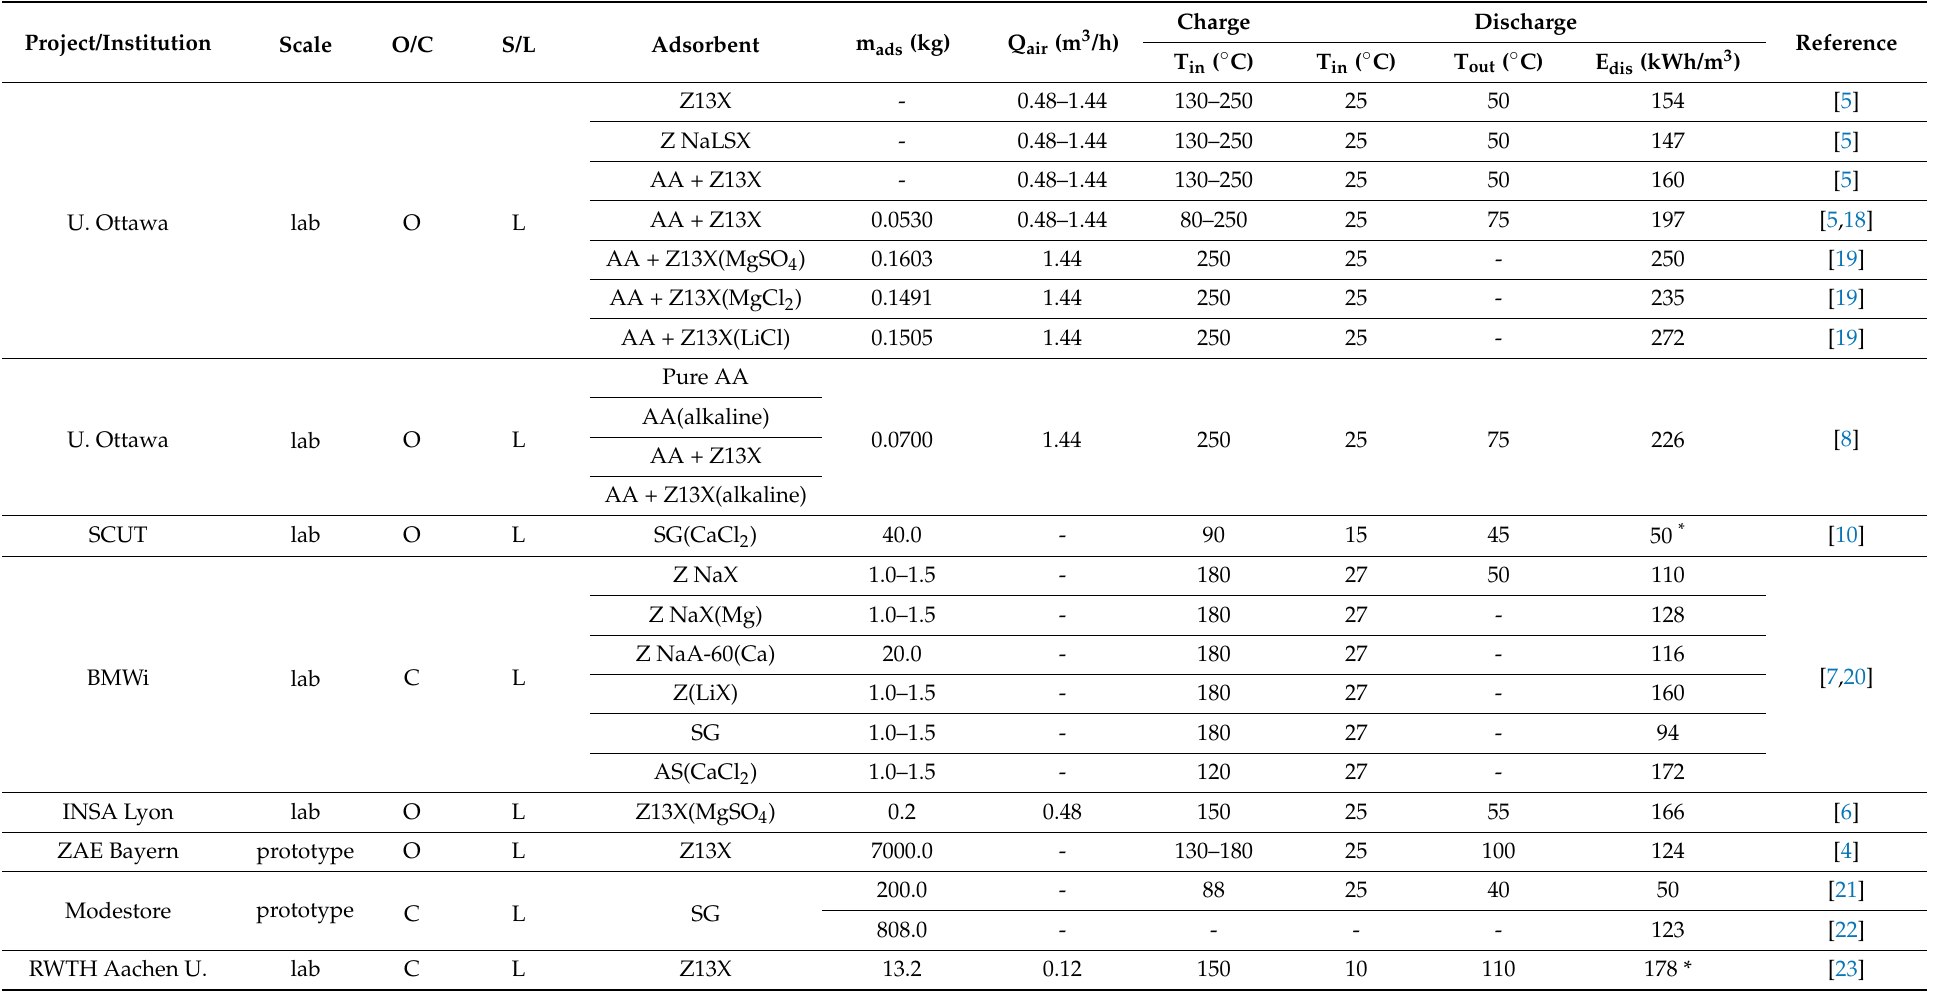
Table 1. Energy storage for thermochemical systems. Information on different experimental